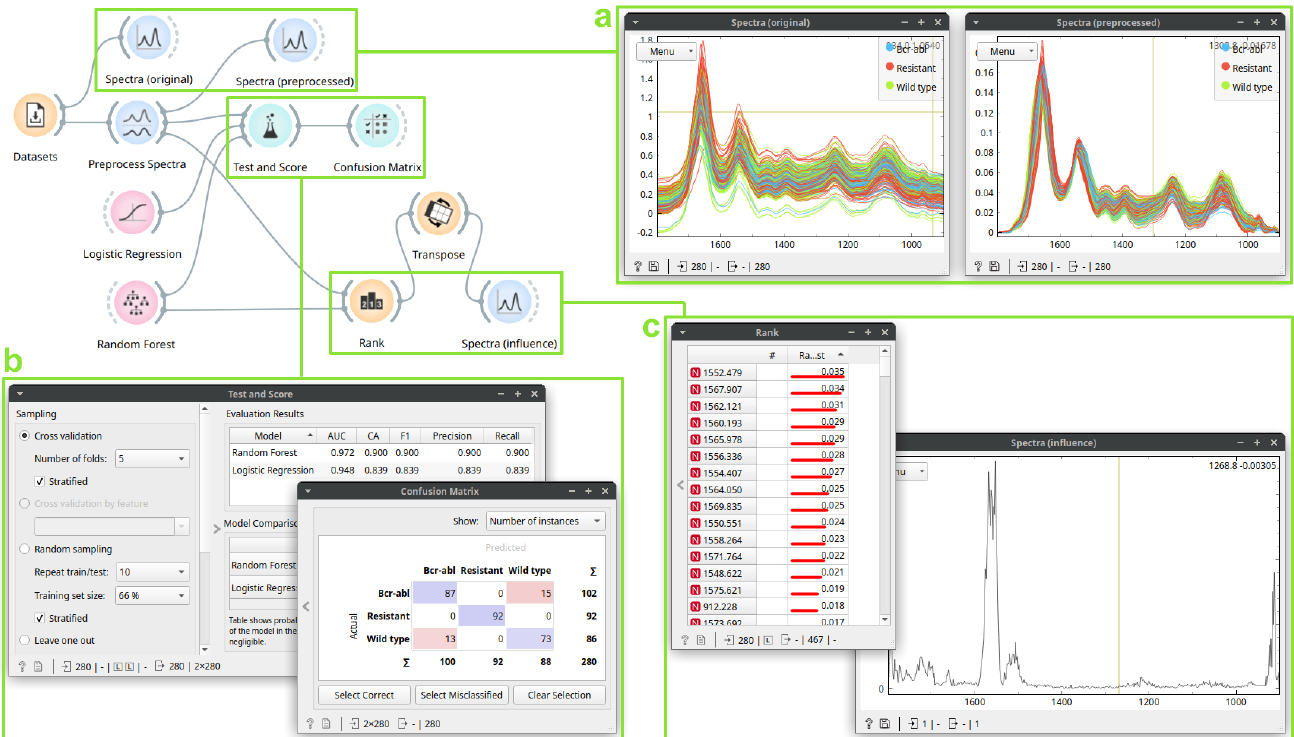
Figure 4. A workflow for supervised analysis of three cell lines. The first Spectra (box a , left ) displays the original data, colored by the cell line. The second Spectra (box a , right ) shows data after preprocessing: Preprocess Spectra applies rubber band baseline and vector normalization. The Test and Score (box b , left ) widget shows cross-validated prediction quality of two methods: Logistic Regression and Random Forest . The Confusion Matrix (box b , right ) widget highlights errors from Random Forests : for the “Resistant” class, there were no errors. Finally, the Rank (box c , left ) shows wavenumber importance for the random forest classifier; these are also shown in the Spectra (box c , right ) widget: the region 1600–1500 cm − 1 is the most important for